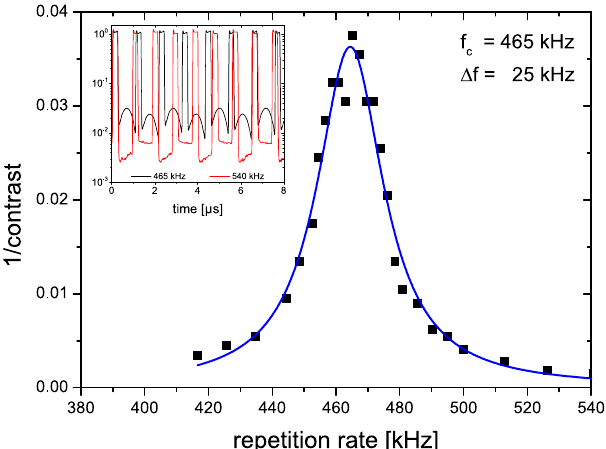
Figure 2. Dynamic polarization contrast of the BBO Pockels cell vs. repetition rate when supplied voltage = 0; Inset: Polarization contrast vs. time at two repetition rates.